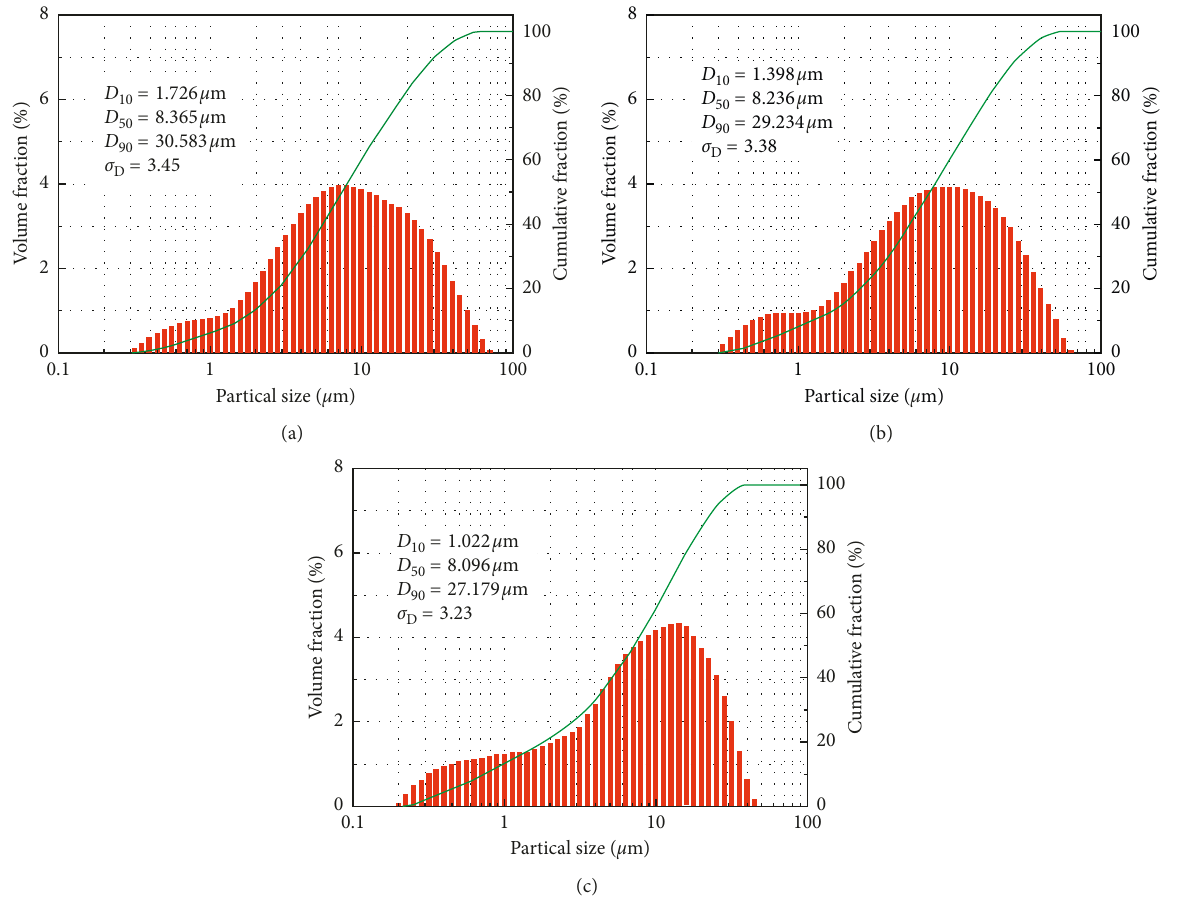
Figure 1: Particle size distribution: (a) HM; (b) QM; (c) WY. Table 1: Proximate analyses of the coal samples. Proximate analyses Sample